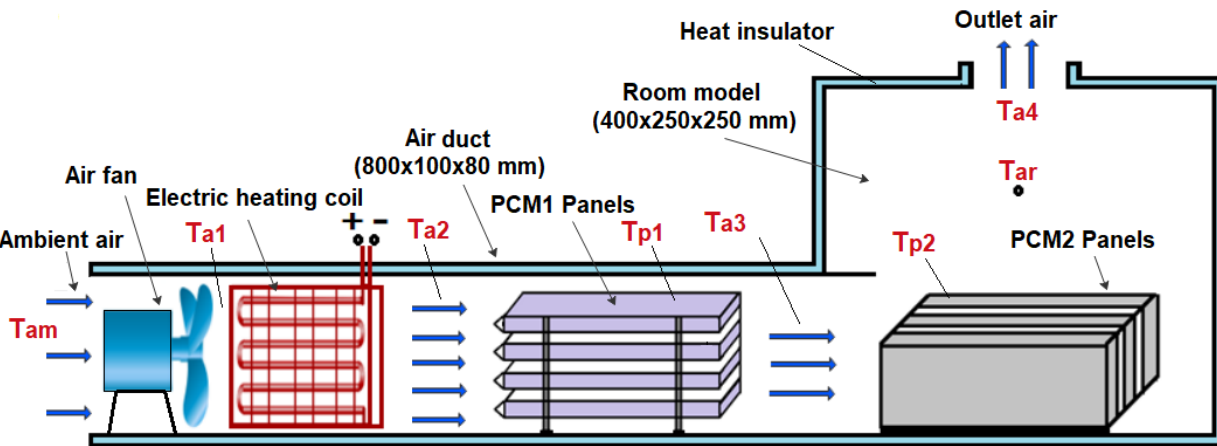
Figure 1. Schematic diagram of the experimental setup.